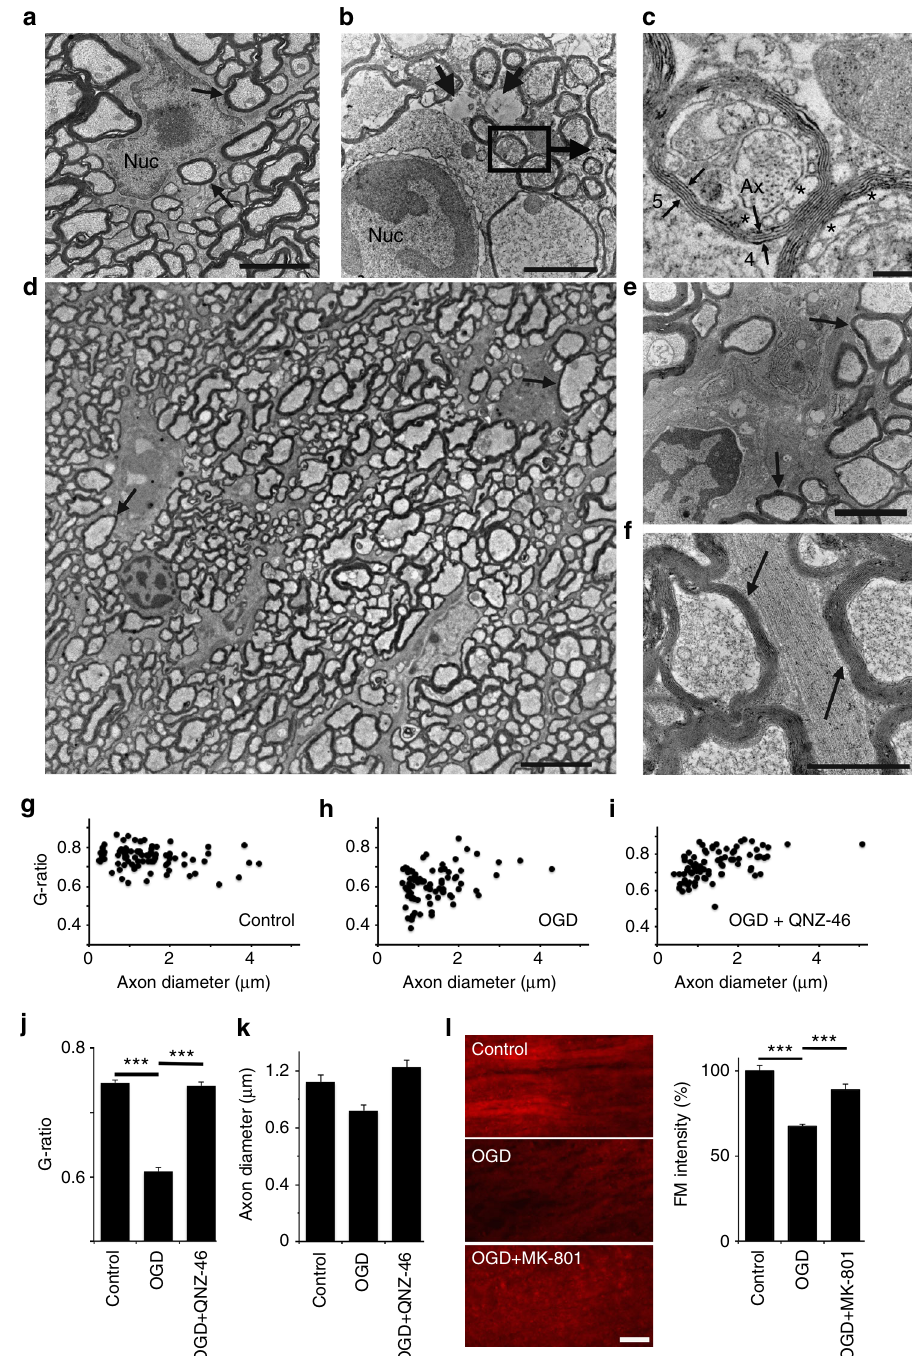
Fig. 5 Myelin protection in adult mouse RON. a Oligodendrocyte (Nuc = nucleus) and myelinated axons (e.g., arrows) in control RON have a normal healthy structure. b , c Following OGD there is glial disruption including nuclear condensation and process degeneration (e.g., short arrows) with myelin disruption in the axon population. Note that the inner myelin layers are often separated and may form bubbles. For example in ( c ) (higher power image of the boxed area in ( b )) where a region of myelin on the left side of the axon has fi ve layers (small arrows) and no bubbles but the inner layer has four layers with a series of bubble pro fi les on the right side (e.g., *). Note retention of microtubules within the axon pro fi le (Ax). d – f Uniform protection of myelin structure (e.g., arrows) throughout RONs fi xed after OGD + QNZ-46. Note that glial cell soma ( d , e ) and processes ( f ) also retain normal structure in this protocol. g – j Myelin thickness assessed as G-ratio under the three conditions, showing myelin expansion following OGD (ANOVA with Holm − Š ídák post test; P = 0.0001) and prevention of this effect by perfusion with QNZ-46 ( P = 0.0007). j , k Mean data showing the changes in G-ratio under these conditions ( j ); which are not accounted for by signi fi cant axonal shrinking ( k ). l Myelin stained with fl uoroMyelin (FM) under these conditions (left) and (right) the mean FM intensity decline evoked by OGD ( P = 0.00027), which is prevented by MK801 ( P = 0.00062). Bar a , b , e , f = 1 μ m; d = 5 μ m; c , l = 100